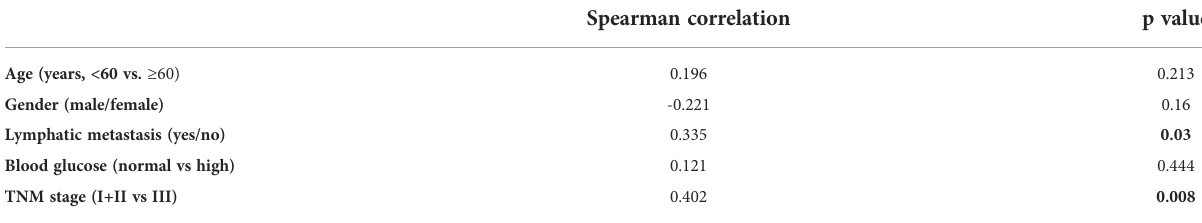
TABLE 3 Spearman analysis of correlation between DEPDC1 and